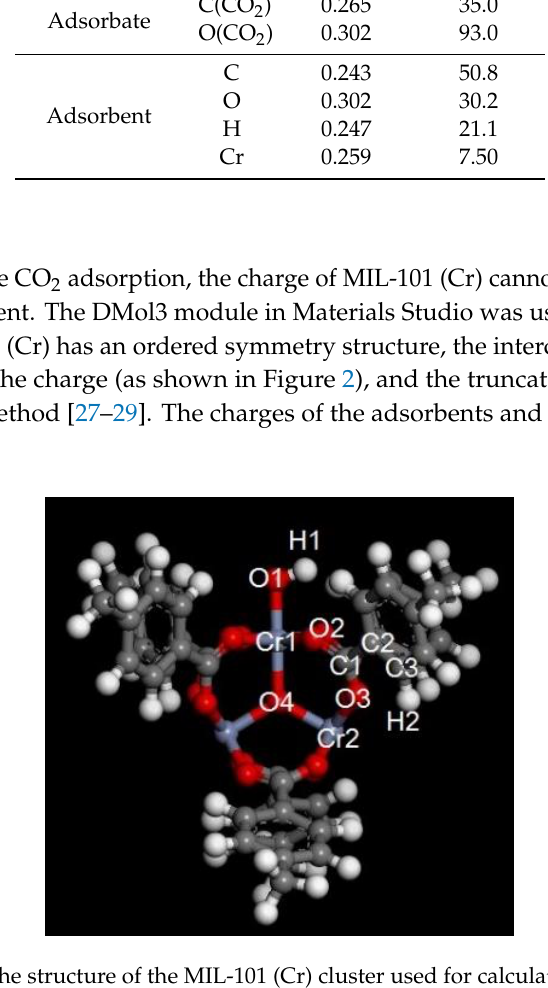
Figure 2. The structure of the MIL-101 (Cr) cluster used for calculating